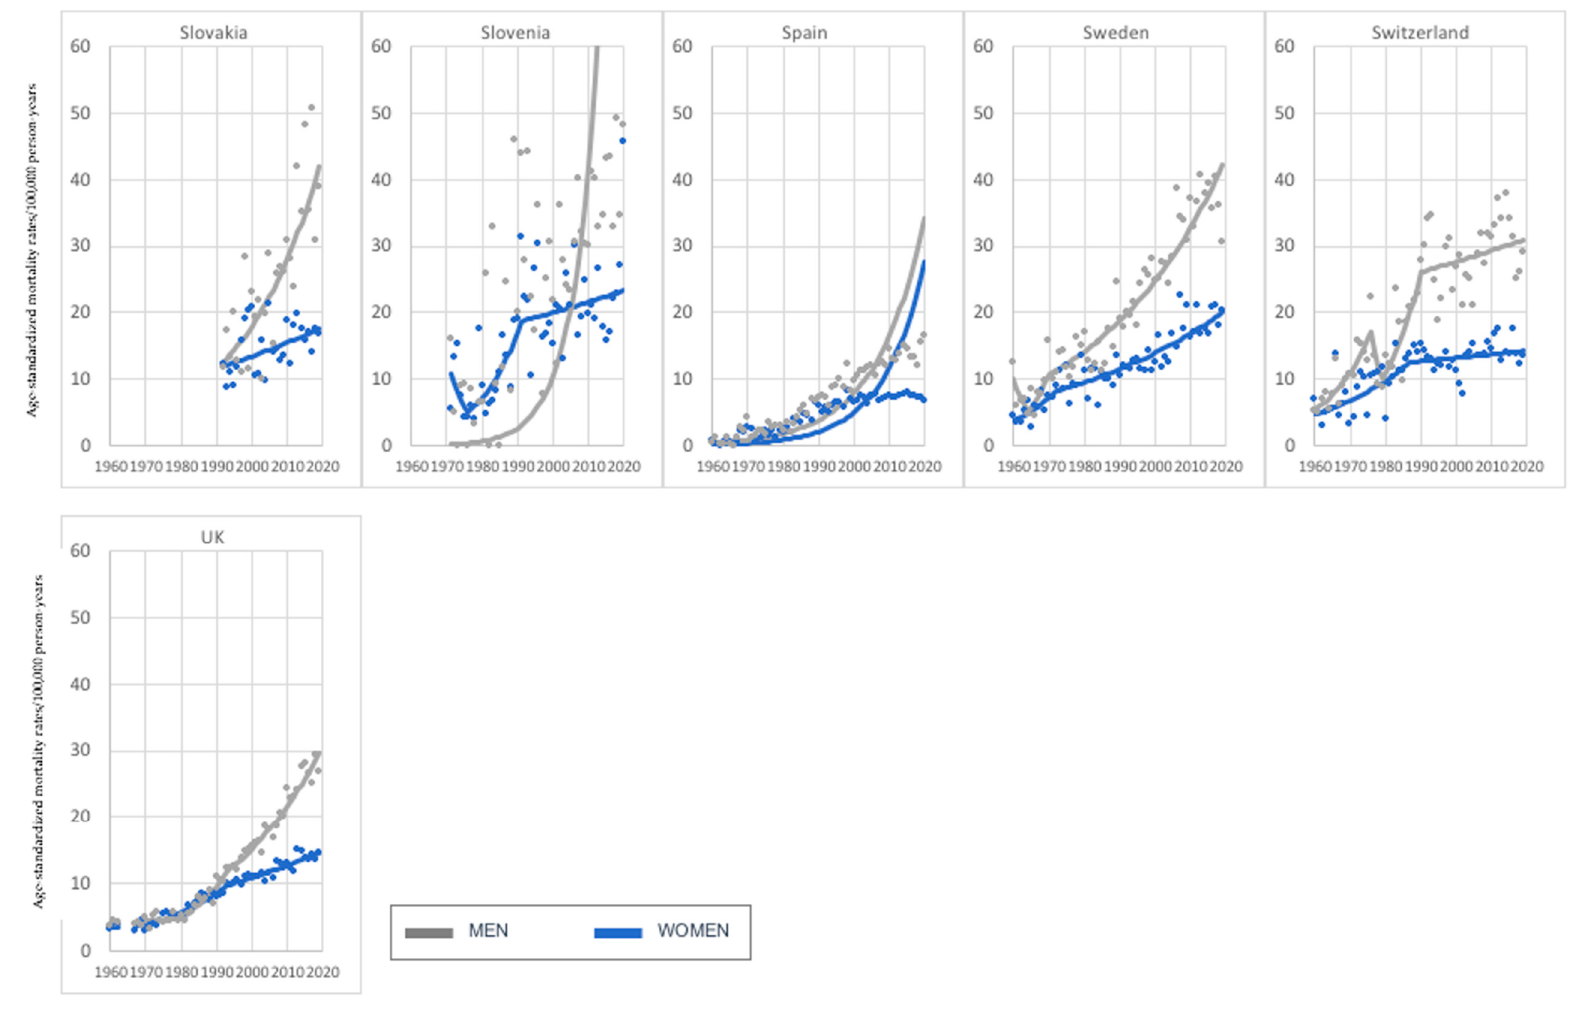
Figure 6. Melanoma mortality trends—26 countries with investigated increase in both sexes, age group 75+ years old.